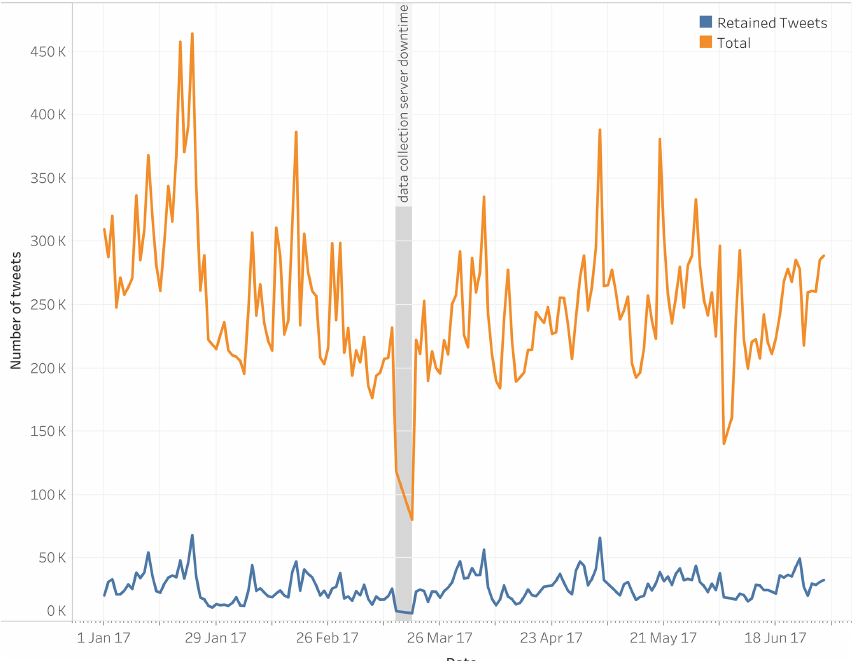
Figure 1. Number of tweets collected per day between 1 January and 30 June 2017. Data shown for both the total number of tweets collected (top line) and the number of tweets retained after filtering for relevance (bottom line). The period where the tweet collection failed (16– 18 March 2017) is shown by a grey bar.